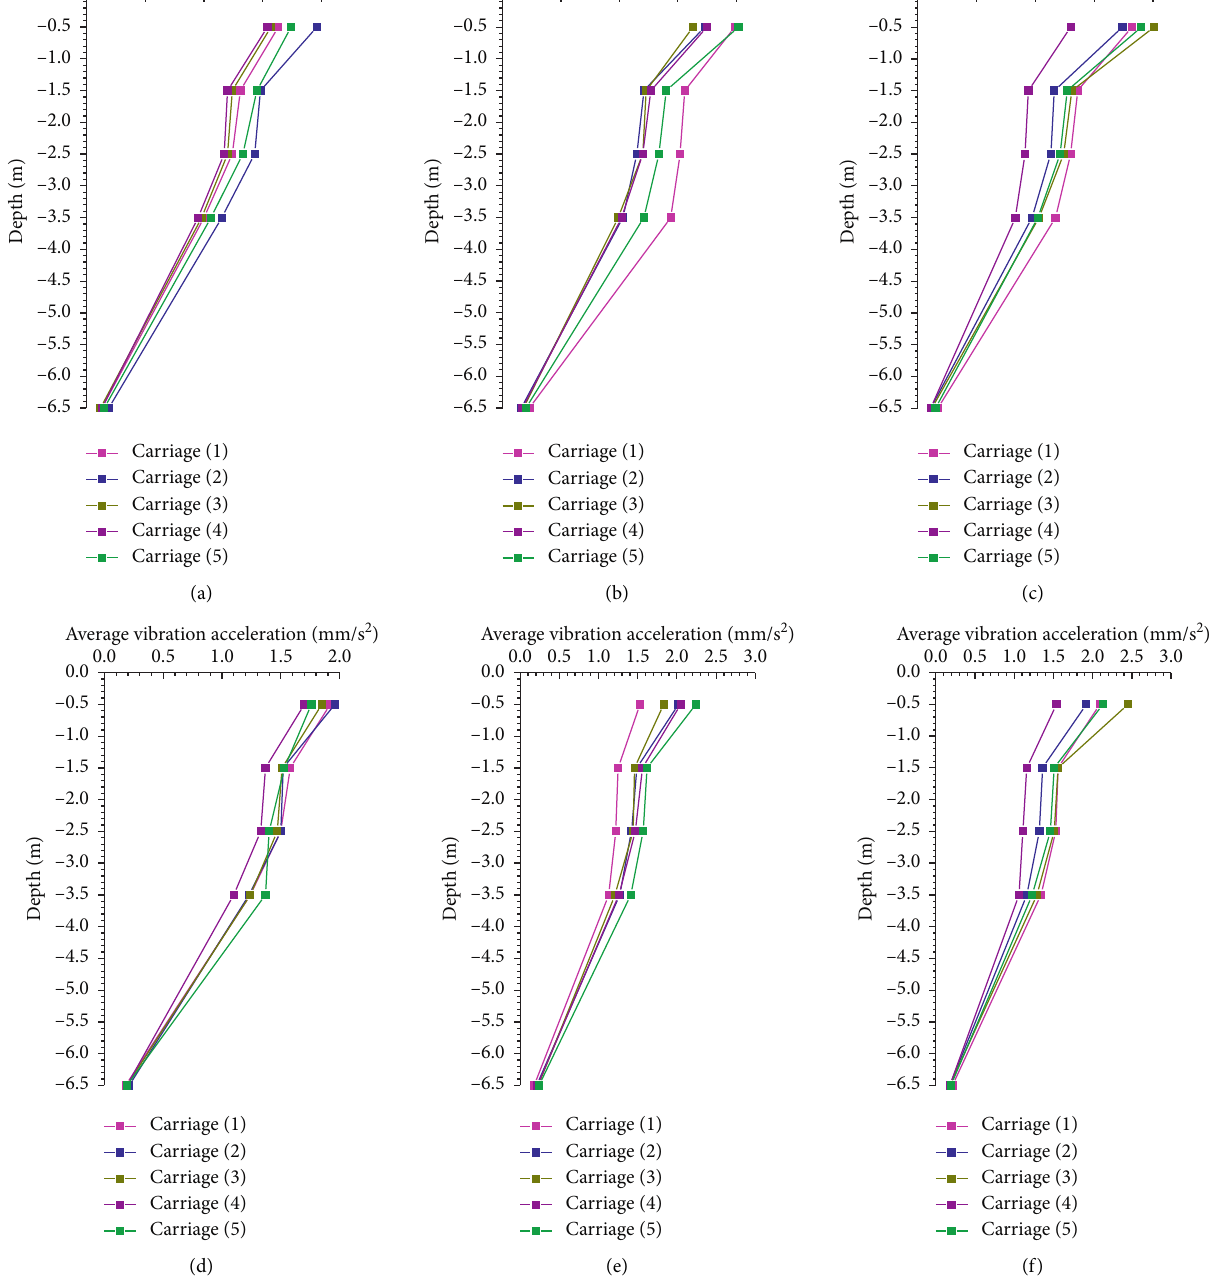
Figure 12: Effective value and average value of vertical vibration acceleration at K330+990 measuring point. (a) Effective value attenuation curve in September 23rd. (b) Effective value attenuation curve in October 11th. (c) Effective value attenuation curve in October 22nd. (d) Average attenuation curve in September 23rd. (e) Average attenuation curve in October 11th. (f) Average attenuation curve in October